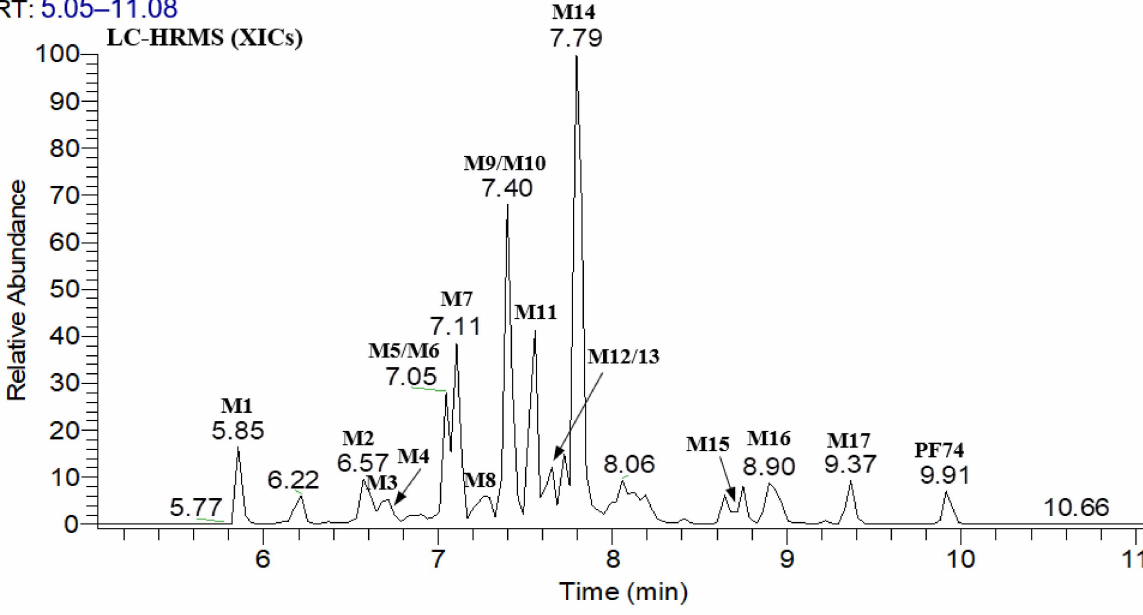
Figure 3. XIC of PF74 in HLMs.